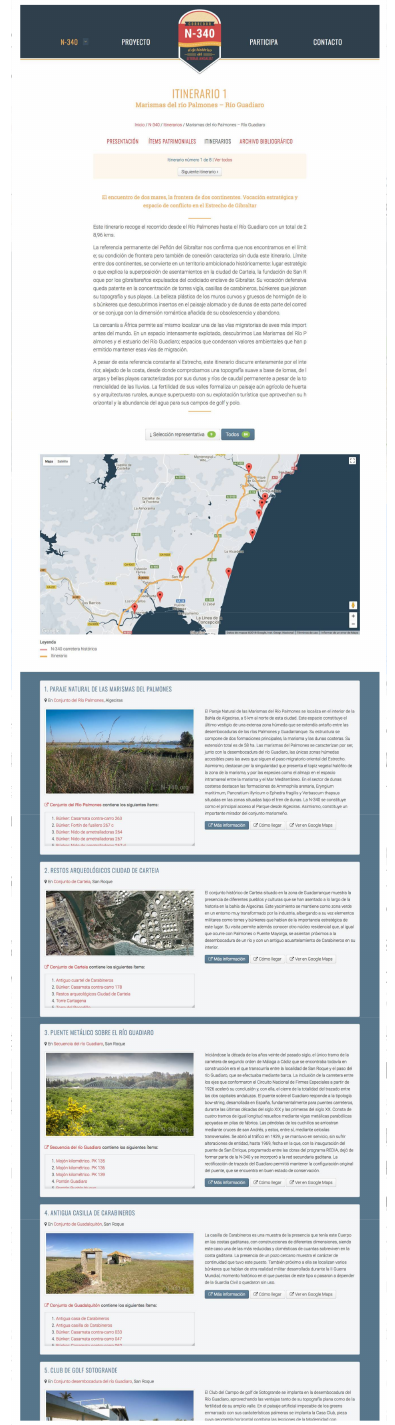
Figure 10. Itinerary 1: Marismas R í o Palmones—R í o Guadiaro (Marshes of Palmones River—Guadiaro River). “The encounter of two seas, the frontier of two continents. Strategic vocation and space conflict in the Strait of Gibraltar”. The nine representative items along the N-340 road are shown on a Google map and summarized